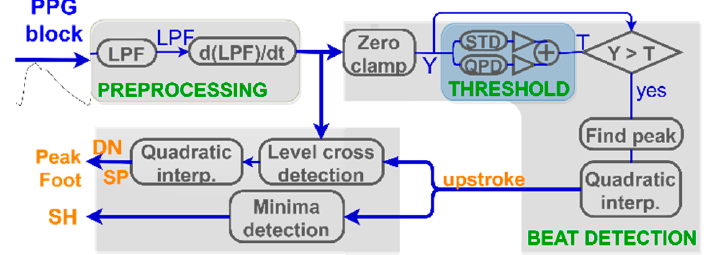
Figure 8. PPG algorithm’s block diagram: each PPG block is processed to find locations of characteristic points (orange): LPF (low-pass filter), Y (zero-clamped LPF), STD (standard deviation), QPD (quasi-peak detector), and T (threshold).